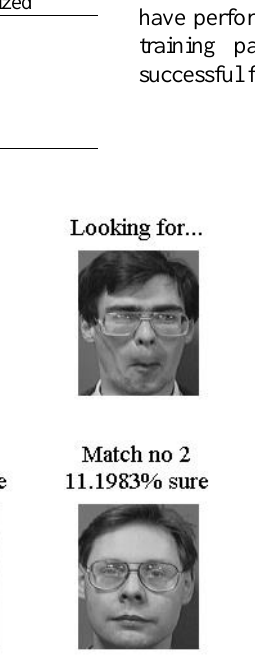
Figure 2. Face recognition example using traincgb as training function